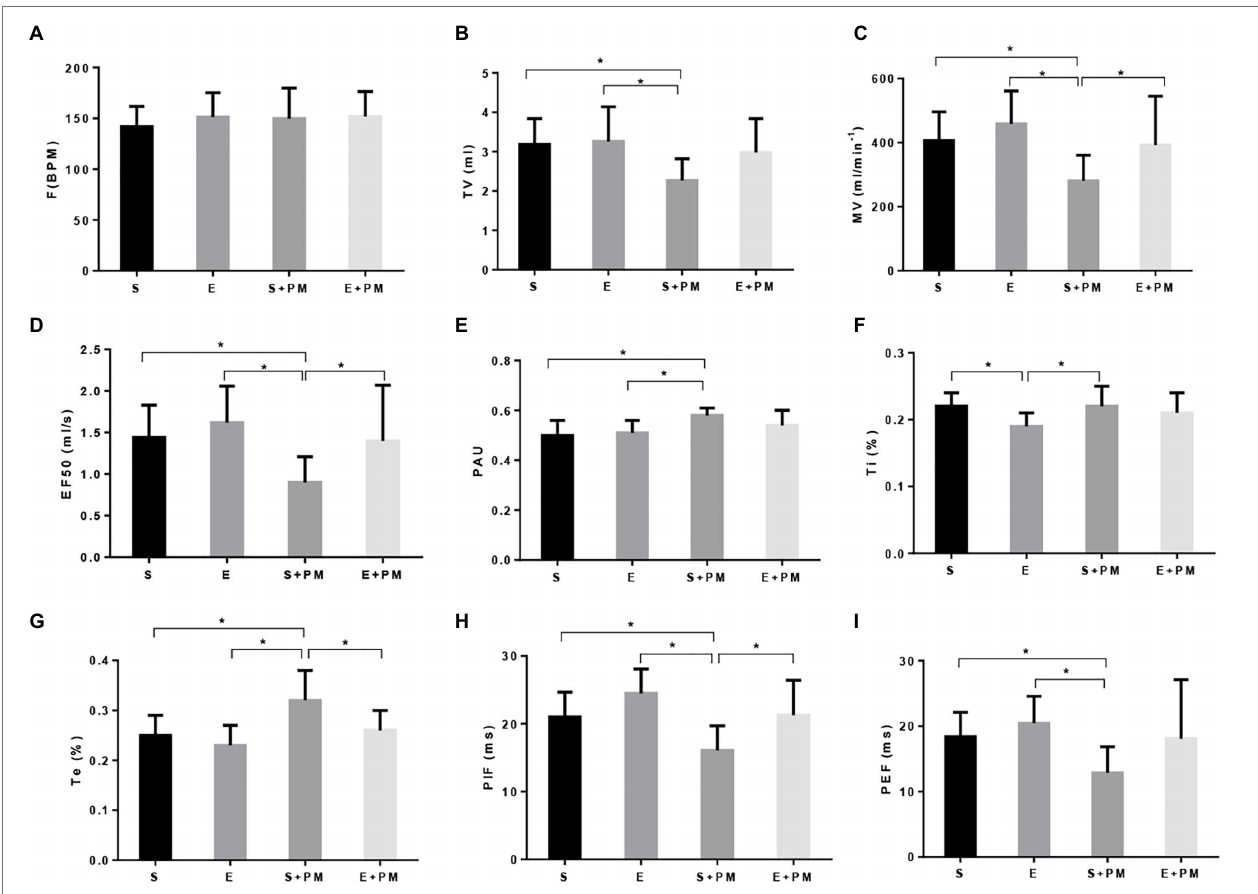
FIGURE 2 | Aerobic exercise protected rats from PM 2.5 -induced pulmonary function decrease. (A) Breathing frequency ( F ). (B) Tidal volume (TV). (C) Minute ventilation (MV). (D) Forced expiratory flow-50% (EF50). (E) Pause (PAU). (F) Inspiration time (Ti). (G) Expiration time (Te). (H) Estimated peak inspiratory flow (PIF). (I) Estimated peak expiratory flow (PEF). Data represent mean ± SD. * p < 0.05 between